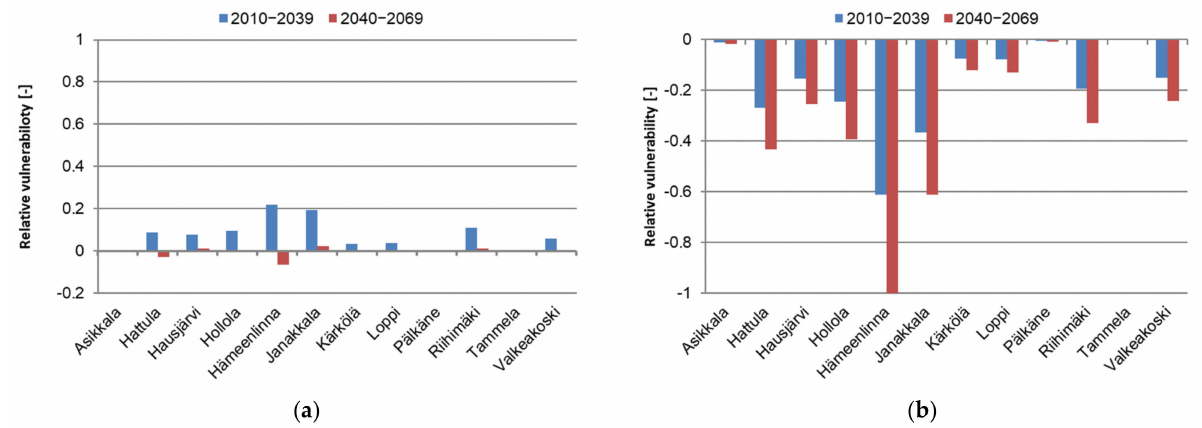
Figure 10. Highest and lowest vulnerability in different municipalities according to two extreme scenarios: ( a ) CNRM RCP4.5, ( b ) Had